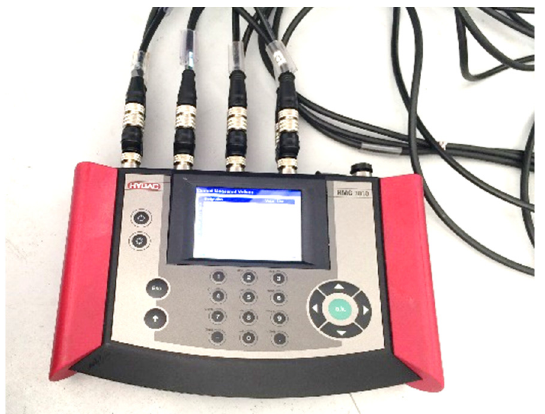
Figure 1. HMG 3110. Figure 1. HMG 3110.